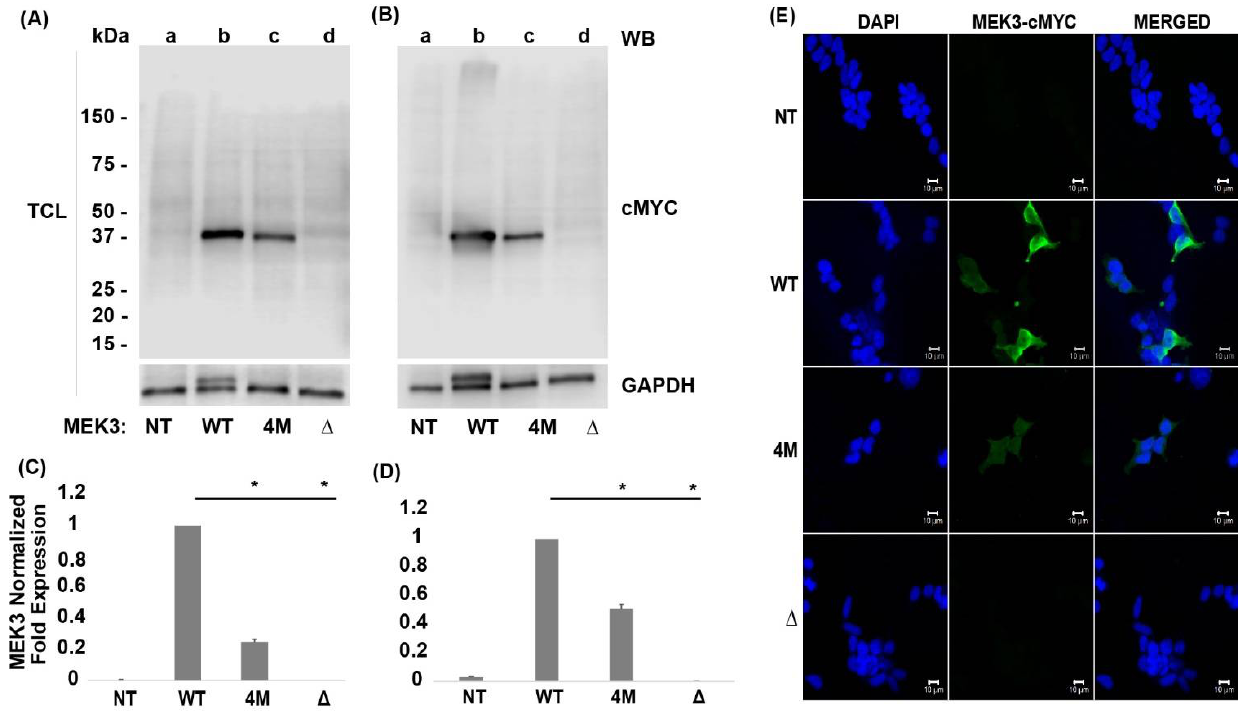
Figure 3. Quadruple and truncated MEK3 mutants decrease protein stability. Cells were not transfected (NT) or transiently transfected concurrently with WT-cMYC or MEK3-cMYC mutant constructs. ( A ) Total cell lysates (TCL) from HEK293 ( B ) and HEPG2 cells transfected with either WT, quadruple (4M), or truncated (Δ) MEK3 constructs, separated by SDS-PAGE (4–20%) and immunoblotted (WB) as indicated. MEK3 protein expression band intensities were normalized to GAPDH using densitometric analysis. ( C ) Quantification of MEK3 mutant protein expression relative to WT in HEK293 and ( D ) in HEPG2 cells. Data are presented as mean ± SEM ( n = 3). One-way ANOVA with post hoc Tukey’s test for multiple comparisons was used to determine statistical significance * p < 0.01. ( E ) Immunofluorescence of transfected HEK293 cells. Subcellular localization of MEK3 was determined by staining for cMYC (middle panel), and nuclei using DAPI (left panel). Right panel shows merged images. Scale bar 20 µ